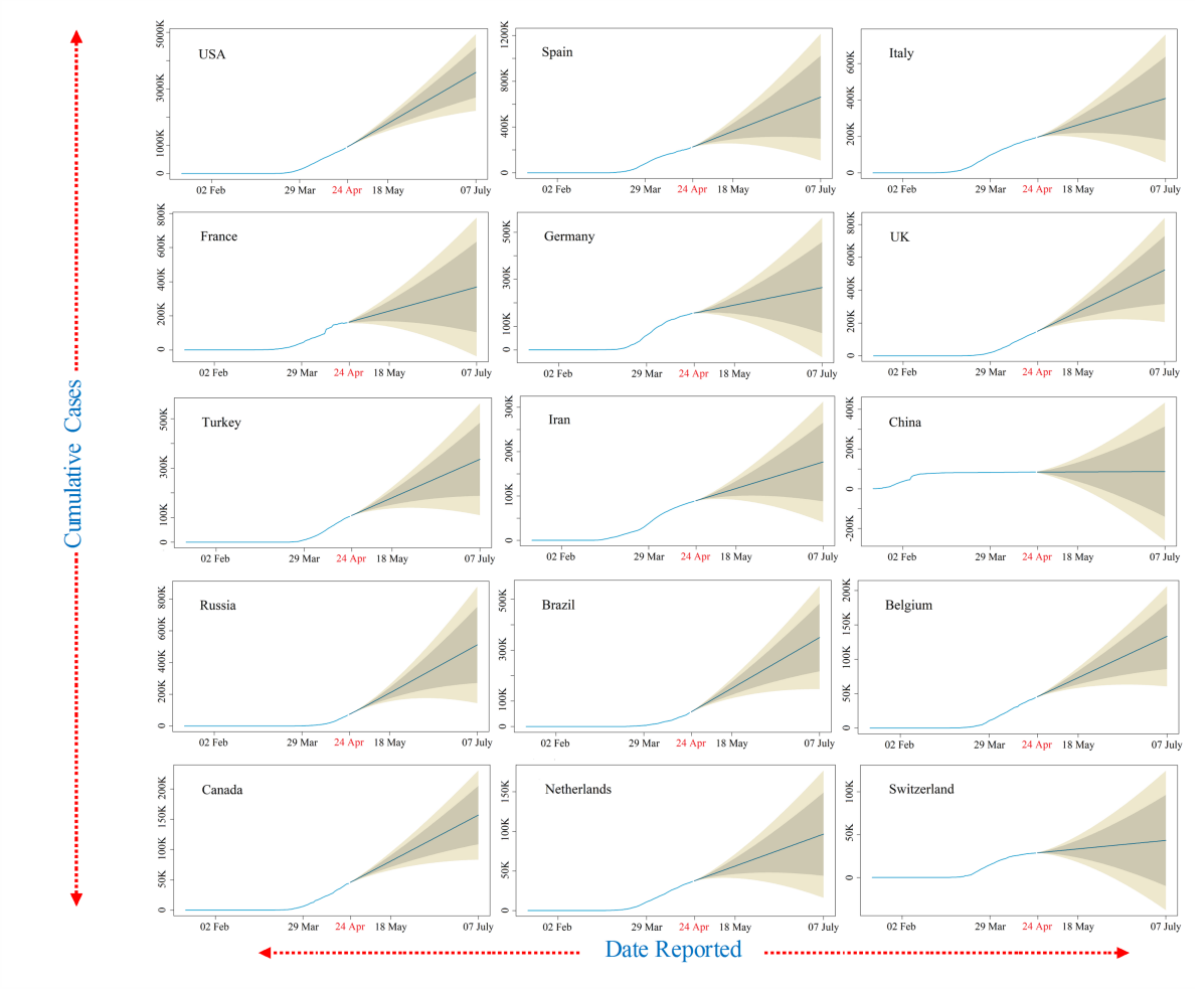
Figure 3. The autoregressive integrated moving average model prediction for more than 2 months of cumulative confirmed coronavirus disease cases in the top 15 affected countries shown in a cyan color (95%